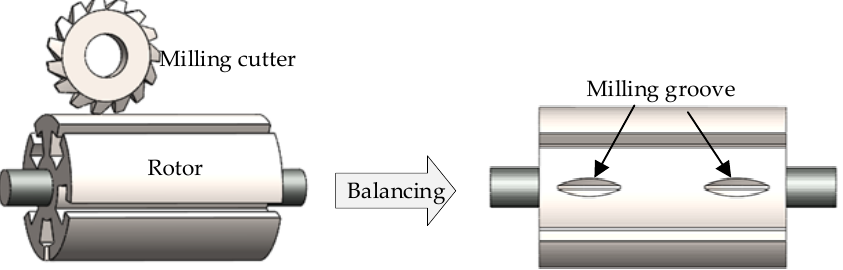
Figure 2. V-shaped milling weight removal model.